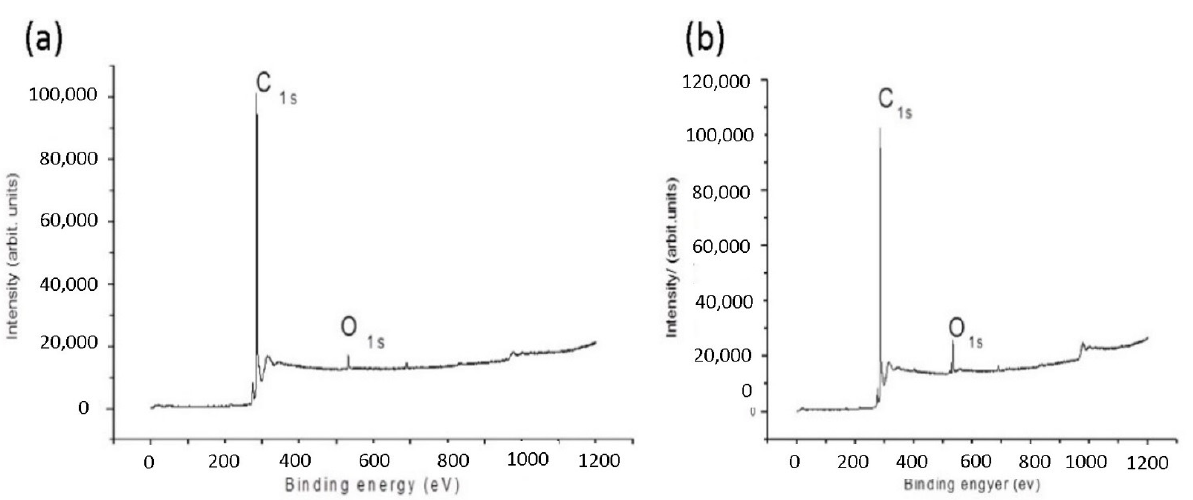
Figure 3. XPS spectra of ( a ) blank graphite and ( b ) oxidized graphite in the range between 0 and 1200 eV.